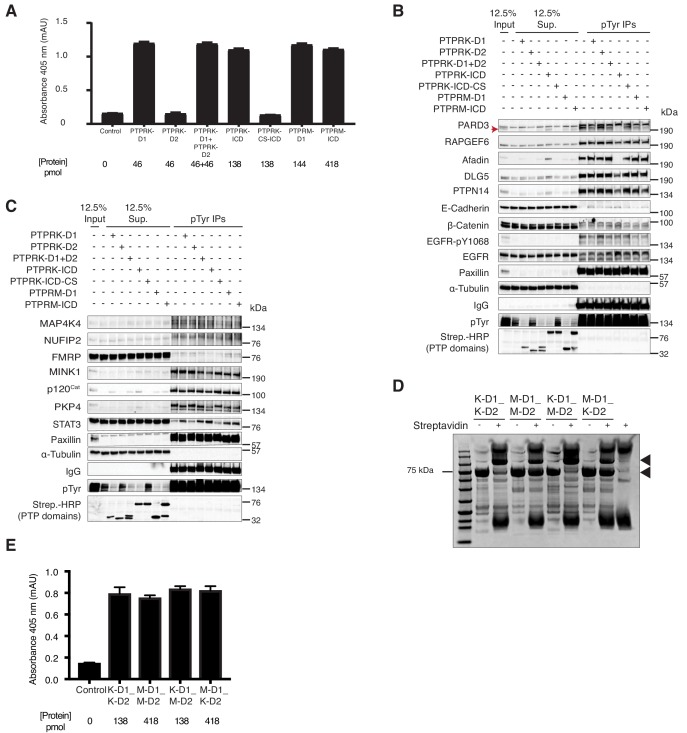
In vitro dephosphorylation assays and generation of RPTP chimeras.(A) The indicated PTPRK and PTPRM domains were assayed for phosphatase activity using the pNPP colorimetric assay. Control wells contained pNPP only. Protein amounts used are shown. (B) Pervanadate-treated MCF10A lysates were incubated with predetermined amounts of the indicated domains to give equal phosphatase-activity, prior to phosphotyrosine immunoprecipitation and immunoblot analysis. (C) Recombinant proteins consisting of combinations of PTPRK and PTPRM D1 and D2 domains were expressed in and using Ni-NTA affinity resin. Purified proteins were then subjected to size exclusion chromatography. (D) Recombinant His- and Avi-tagged PTPRK and PTPRM chimeric domains were purified from E. coli cultured in biotin-supplemented media, incubated ±streptavidin and subjected to SDS-PAGE and Coomassie staining, to determine the extent of biotinylation. Arrows indicate the purified domains and the respective streptavidin-induced mobility shift. (E) The indicated recombinant PTPRK and PTPRM chimeric domains were incubated were assayed for phosphatase activity using the pNPP colorimetric assay. Control wells contained pNPP. Protein amounts used are shown.